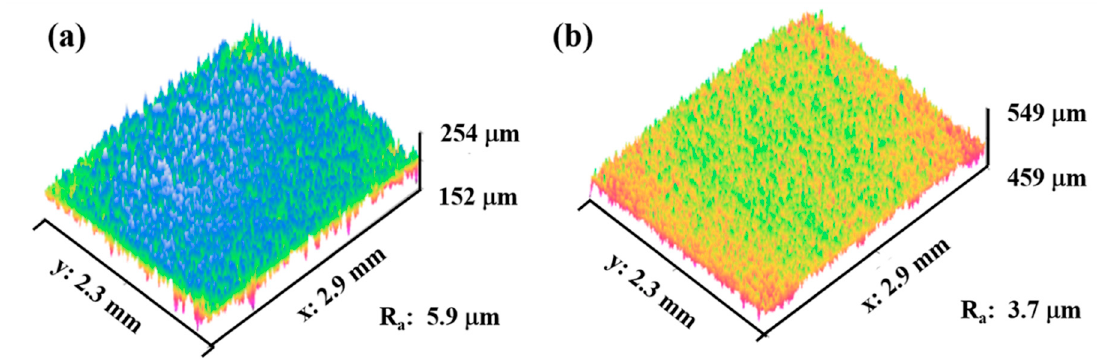
Figure 3. Three-dimensional surface topographies of FG-TBC: ( a ) as-sprayed surface and ( b ) laser-glazed surface. Laser glazing reduces roughness of ceramic coating.